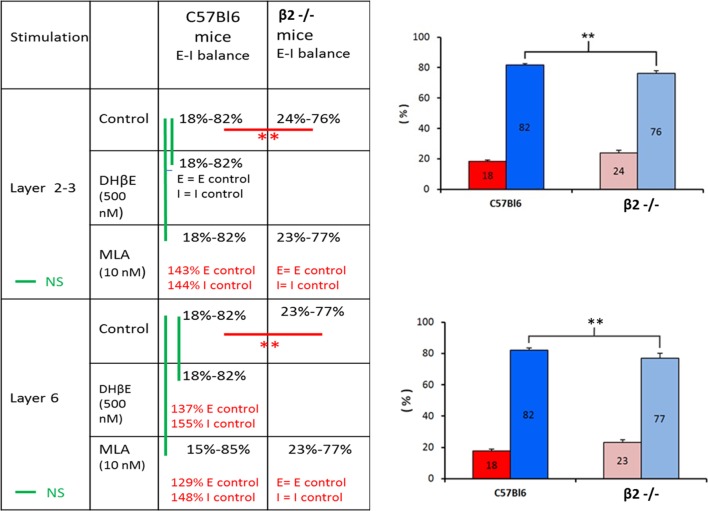
Effects of DHβE and MLA on the E–I balance. Right panel. Significative changes in the E–I balance determined in layer 5 pyramidal neurons between WT mice and β2−/− mice whatever the location of the stimulus (layer 2-3 or layer 6). Left panel. The table summarized the effects of DHβE and MLA on excitatory and inhibitory conductances. Red bars: significative changes in the E–I balance. Green bars: non-significative changes in the E–I balance.